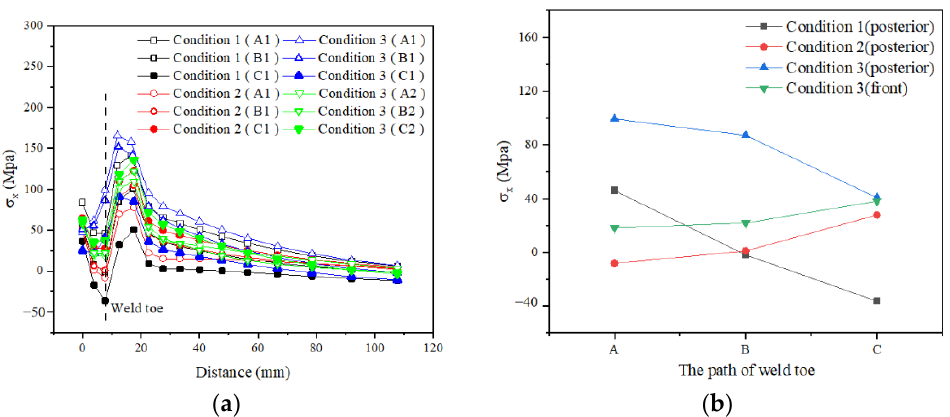
Figure 25. Residual stress distribution of σ x in different welding conditions. ( a ) Along the path direction; ( b ) Position of weld toe.